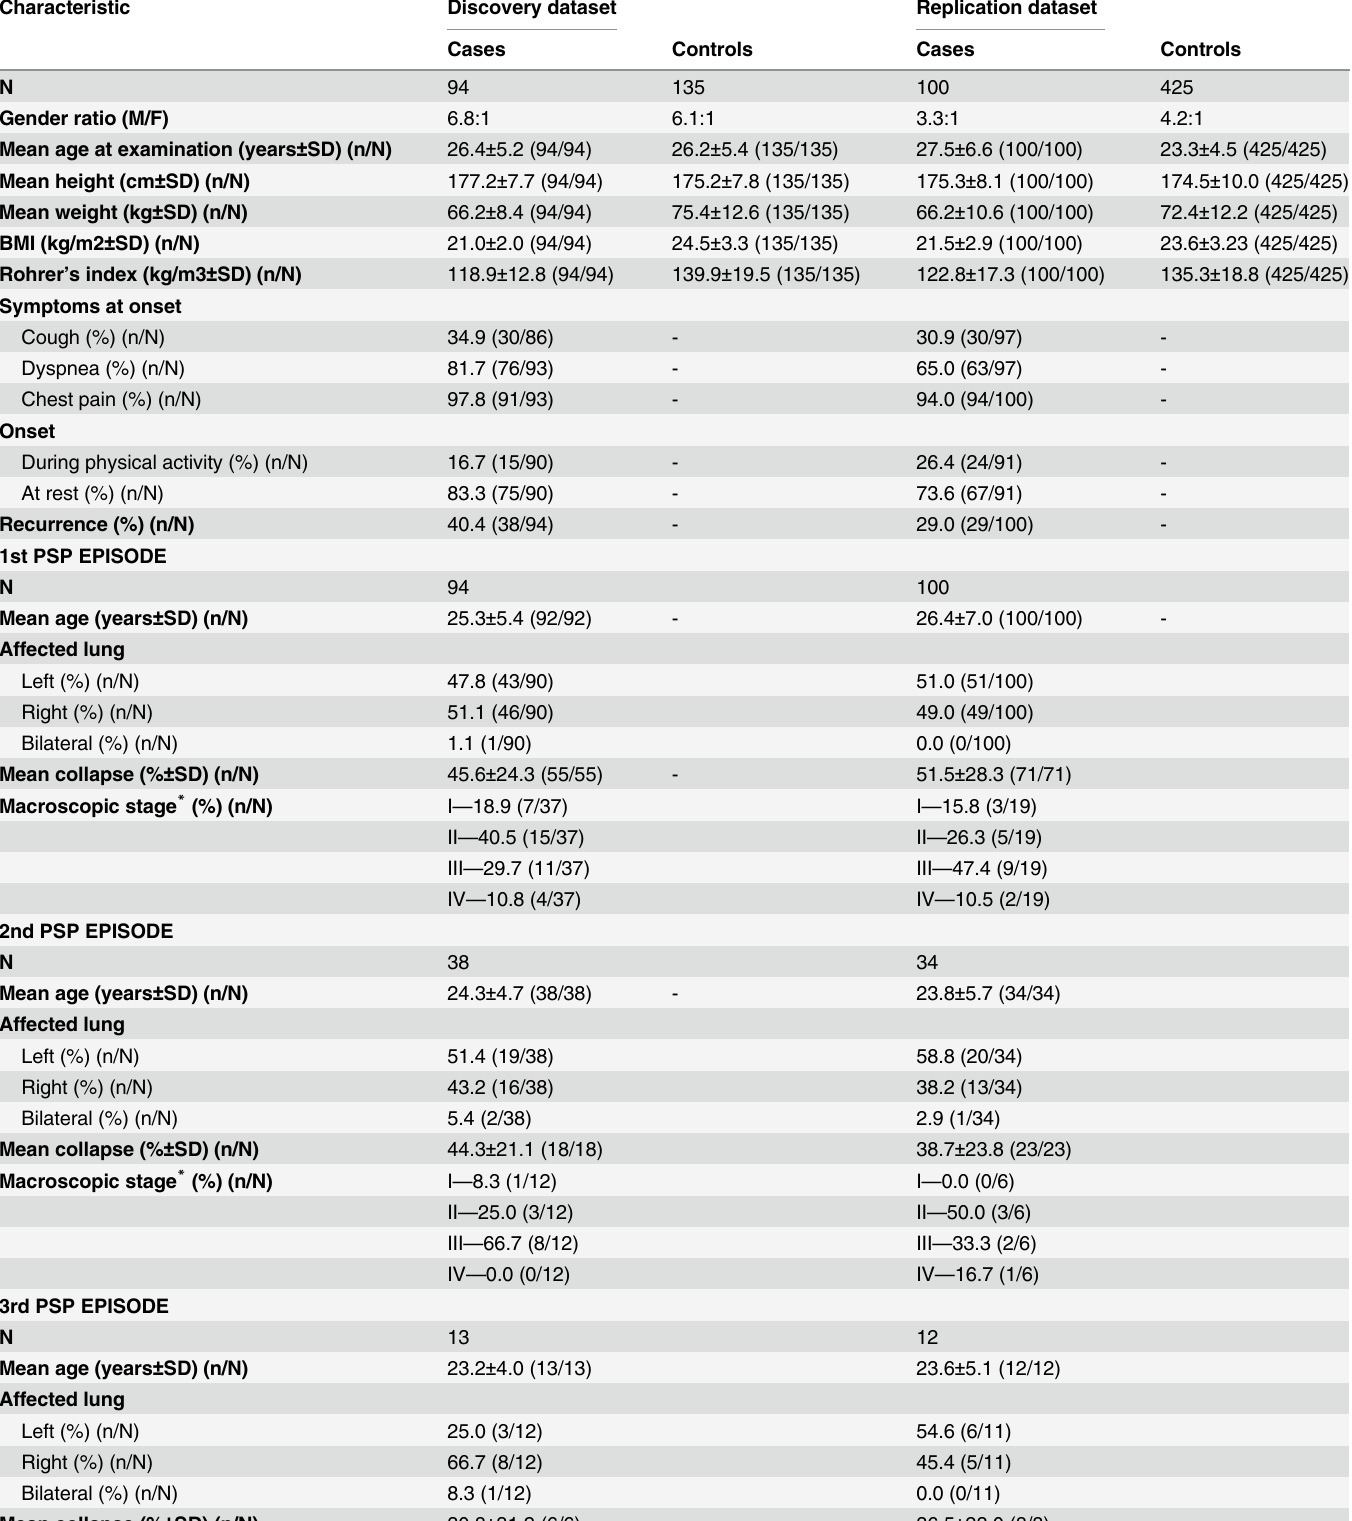
Table 1. Main clinical and demographic characteristics of the PSP case-control discovery and replication